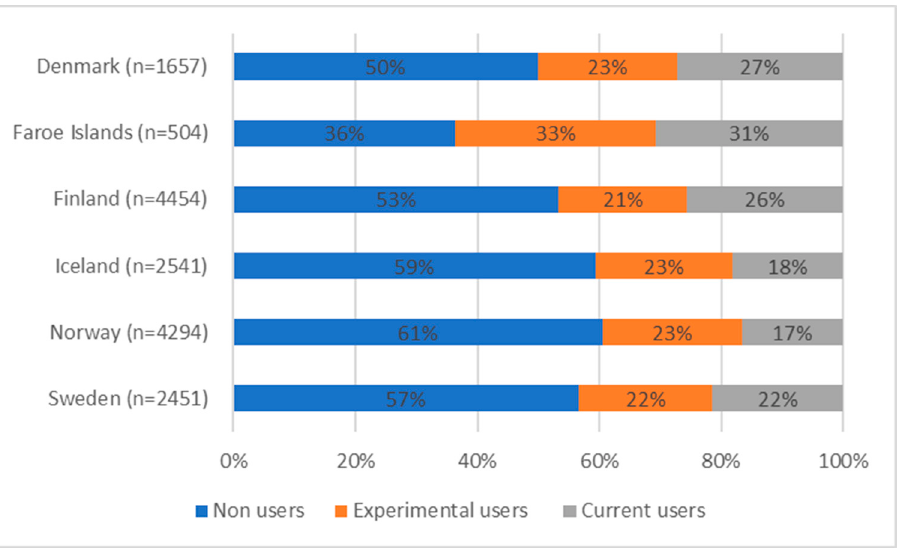
Figure 1. Proportions of students with experimental or current use of at least one tobacco or nicotine product, by country.